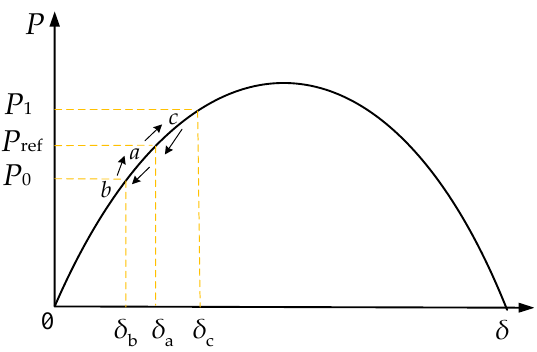
Figure 7. VSG active power and virtual frequency curve.